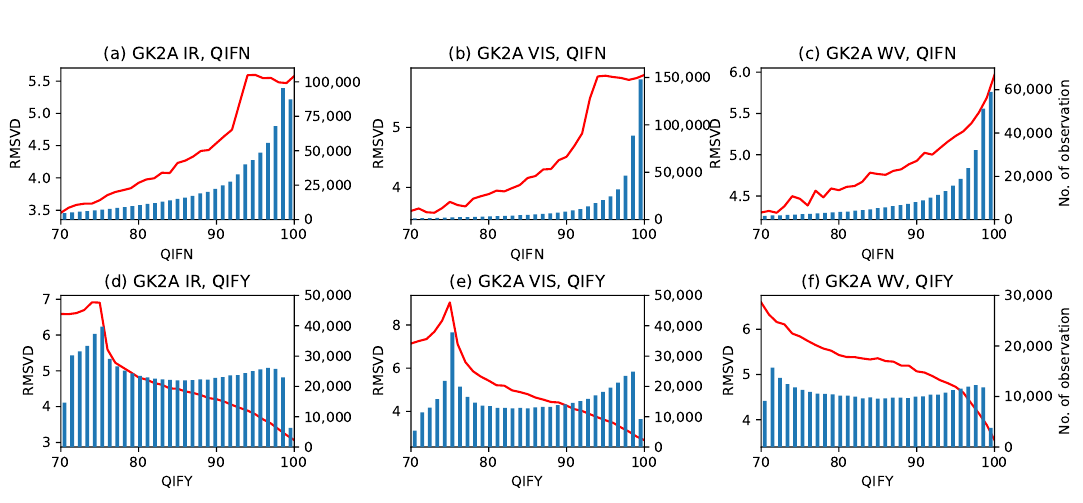
Figure 1. Relationship between Root Mean Square Vector Differences (RMSVD) and forecast inde- pendent QI (QIFN, a – c ), forecast dependent QI (QIFY, d – f ) for the IR ( a , d ), VIS ( b , e ) and WV ( c , f ) channel of GK2A during winter (December 2020). Red lines indicate RMSVD values and blue bars show the numbers of AMVs assigned to each